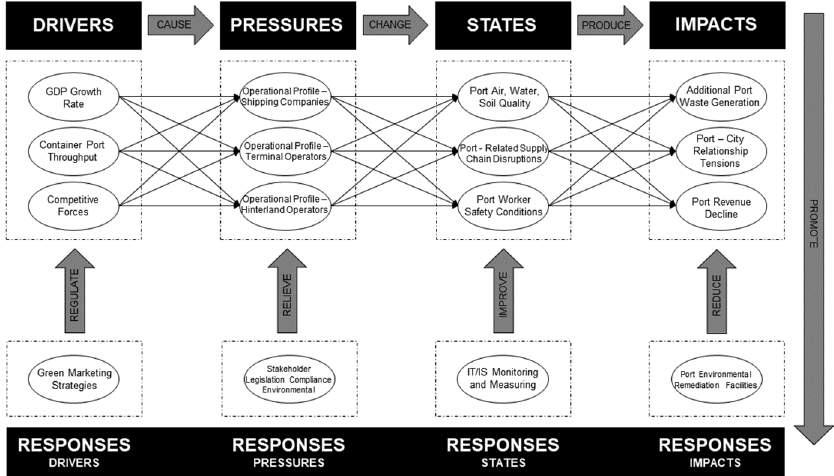
Figure 7. The DPSIR framework of the cause-and-effect relationships of factors influencing the establishment of green port governance models. establishment of green port governance